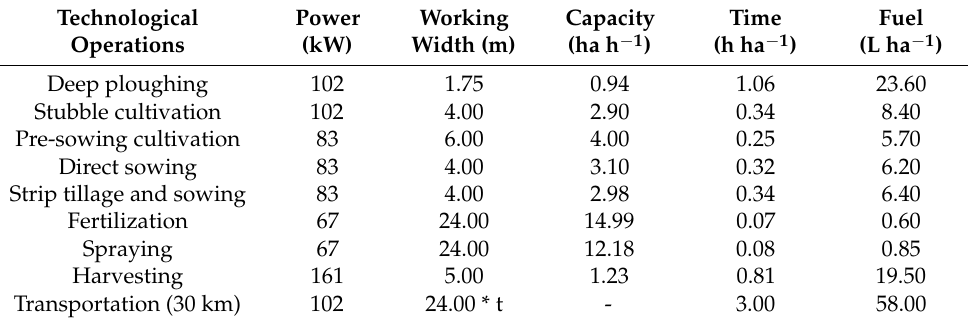
Table 3. Agricultural machinery operations and indicators for winter wheat